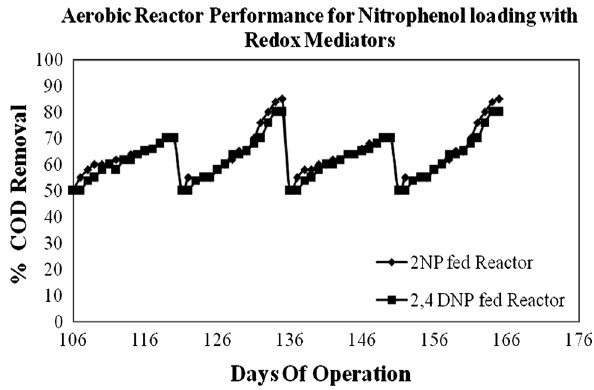
Fig. 9 COD removal for aerobic reactors for 40 mg/l with redox mediators